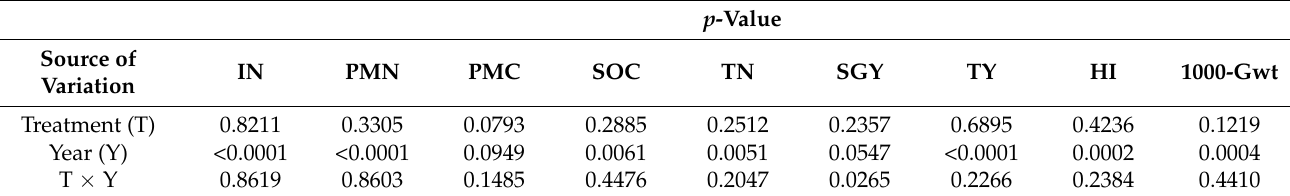
Table 2. Analysis of variance (ANOVA) for soil inorganic nitrogen (IN), potentially mineralizable nitrogen (PMN) and carbon (PMC), soil organic carbon (SOC), total N (TN), sorghum grain yield (SGY), total yield (TY), harvest index (HI), and thousand-grain weight